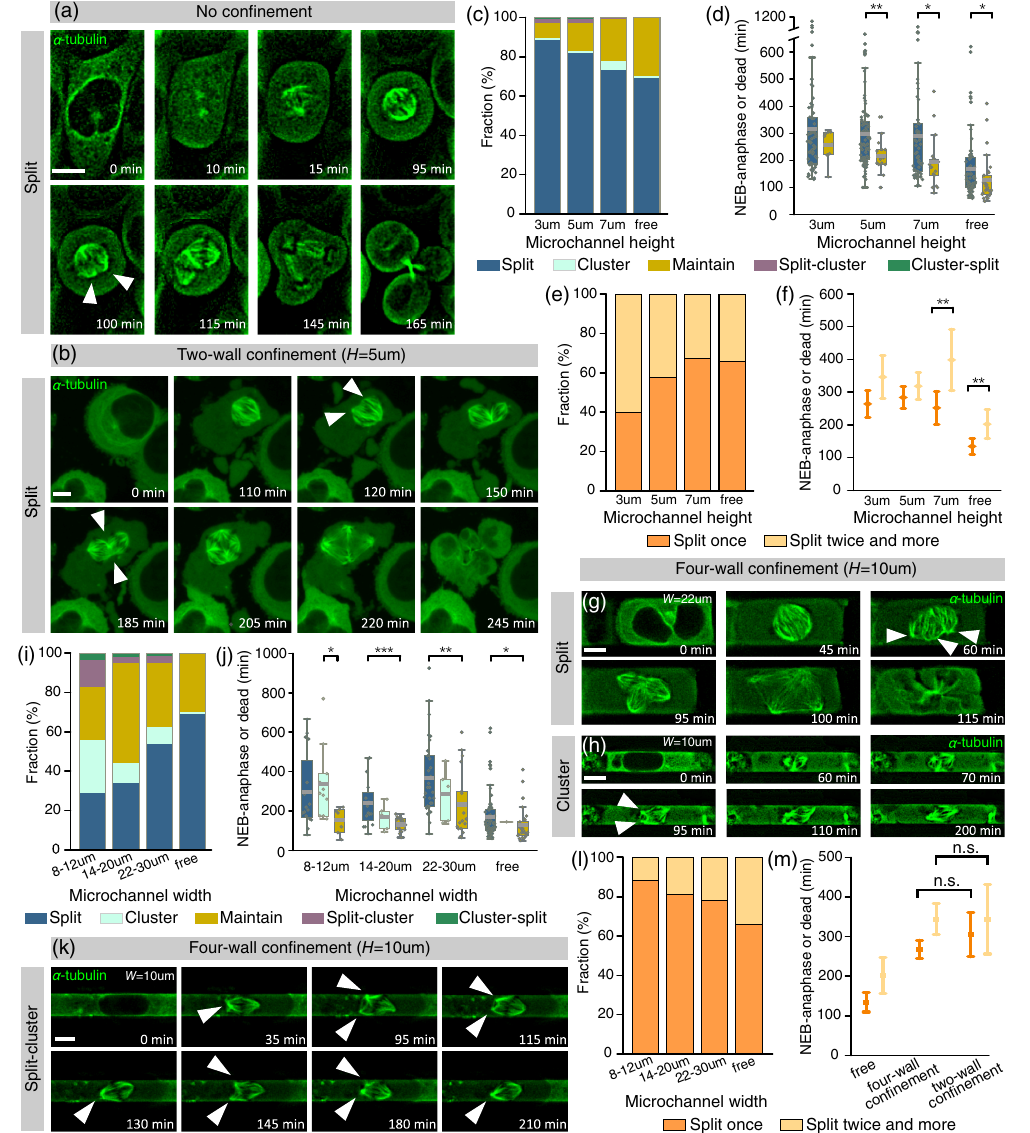
FIG. 2. Two-wall confinement leading to more multipolar spindles by pole splitting and four-wall confinement restraining multipolar spindles by the inhibition of splitting and the enhancement of clustering. (a) Time-lapse images from NEB to telophase show pole splitting under no confinement. (b) Cell under 5 μ m height confinement suffering from twice the splitting followed by tetrapolar division. (c) Among all the multipolar spindles, the fraction of pole splitting, clustering, “ splitting-clustering ” (first split and then cluster), “ clustering-splitting ” (first cluster and then split), maintaining (pole number of a multipolar spindle remaining unchanged during the mitosis process), and (d) corresponding duration from NEB to anaphase or death under no confinement ( n ¼ 107 ) and two-wall confinement ( n ¼ 98 , 111, and 104). We use the Mann-Whitney test with (cid:2) p < 0 . 05 , (cid:2)(cid:2) p < 0 . 01 , and (cid:2)(cid:2)(cid:2) p < 0 . 001 . The data of clustering, splitting-clustering, and clustering-splitting have been omitted in panel (d) since the data were too few to be statistically significant. (e) Fraction of cells with one or more pole splittings, and (f) the corresponding duration from NEB to anaphase or death under no confinement ( n ¼ 70 ) and two-wall confinement ( n ¼ 85 , 87, and 61). We use the Mann- Whitney test with (cid:2)(cid:2) p < 0 . 01 . Time-lapse images from the NEB to telophase show the pole splitting (g) and clustering (h) under four-wall confinement. (i) Among all the multipolar spindles, the fraction of pole splitting, clustering, splitting-clustering, clustering-splitting, and maintaining, and (j) the corresponding duration from NEB to anaphase or death under no confinement ( n ¼ 107 ) and four-wall confinement ( n ¼ 59 , 59, and 80). The data of splitting-clustering and clustering-splitting have been omitted in panel (j). In panel (k), time-lapse images show the splitting-clustering process under four-wall confinement. (l) The fraction of cells with one or more pole splittings under no confinement ( n ¼ 70 ) and four-wall confinement ( n ¼ 17 , 21, and 41). (m) Duration from NEB to anaphase or death compared in the three cases. We use the Mann-Whitney test (n.s., not significant) with p ¼ 0 . 83393 , p ¼ 0 . 57714 . All scale bars are 10 μ